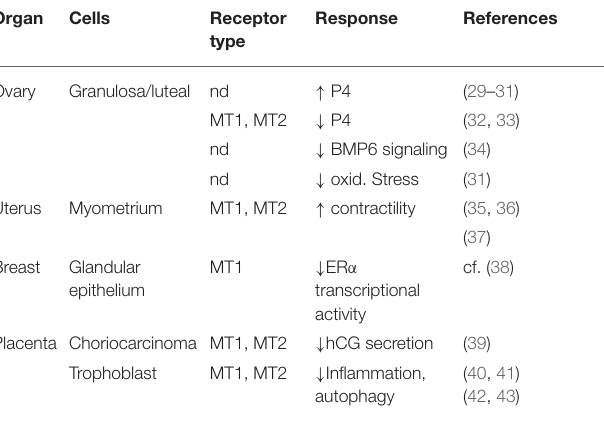
TABLE 1 | Melatonin binding sites in the human female reproductive